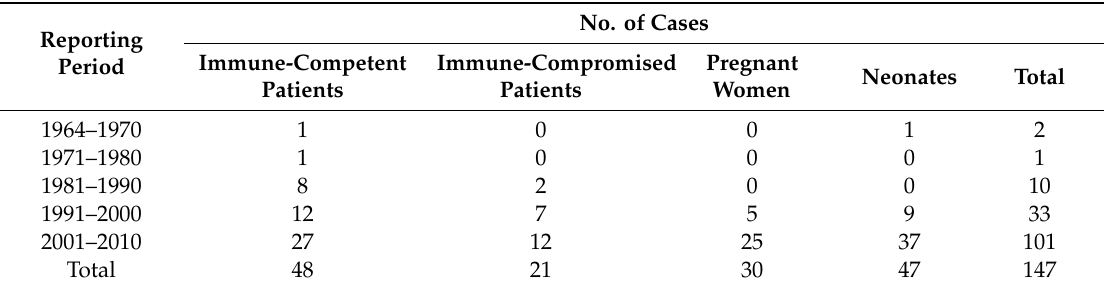
Table 4. Reporting periods of clinical cases of Listeriosis for each subgroup in China, 1964–2010.